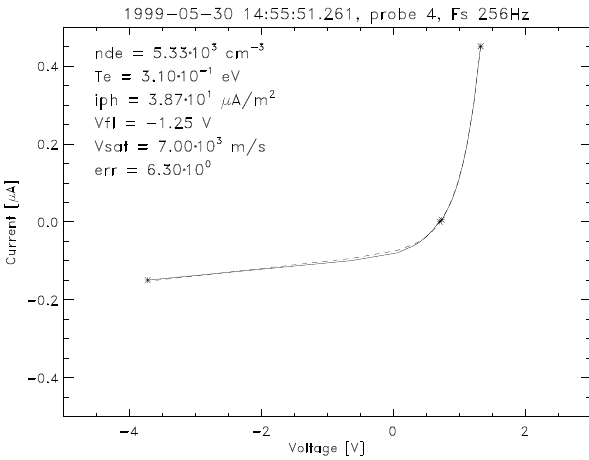
Fig. 2. An example of a multiple EMMA sweep. The upper panel presents the bias current versus sample number, going down and up between − 0.2 and 0.4 µ A twice; the lower panel shows the mea- sured probe potentials for the same samples. Sampling frequency was 2048 Hz, 5 samples with each bias current value were taken.